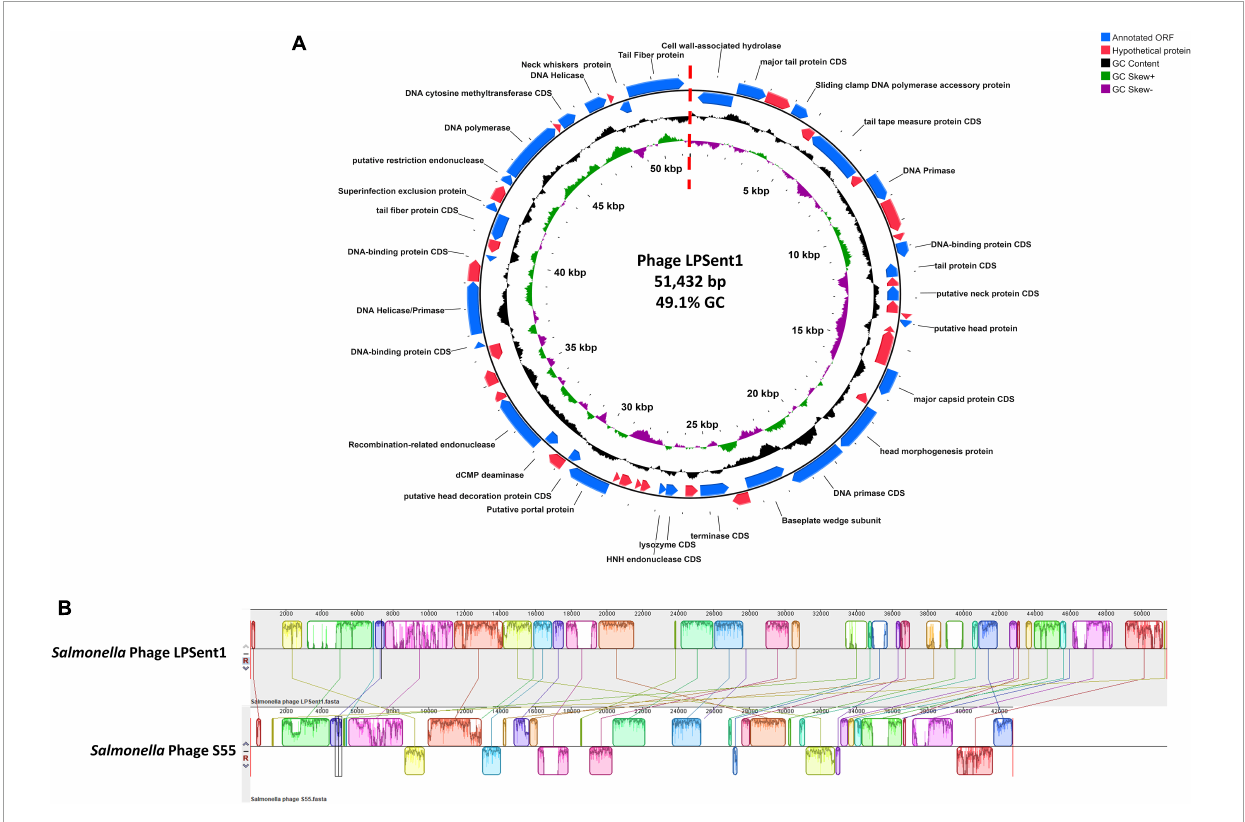
FIGURE4 Phage LPSent1 whole genome analysis. (A) The LPSent1 genome organization represented as a circle. The 59 CDSs are represented as blue or red arrows showing the predicted genes transcribed clockwise (outer side) and counterclockwise (inner side) along the genome. The genome map is a circle, but there is a break at the 12 o’clock position (at the dotted straight red line) because the phage genome is a linear molecule. CDSs with known functions (blue arrows) are labeled with their putative functions along with their position; however, other non-labeled CDSs represent hypothetical proteins (red arrows). (B) Multiple alignment of phage LPSent1 with the most similar phage (phage S55) using progressive mauve alignment on default settings for Salmonella phage LPSent1 (top) and Salmonella phage S55 (bottom). The degree of DNA sequence similarity is indicated by the height of each colored block. Homologous regions are connected by lines between genomes, and blocks below the center line in Salmonella phage S55 indicate sequences with inverse orientation in comparison to phage LPSent1 arrangement. White spaces within blocks represent small-localized areas of the genome sequences that were not